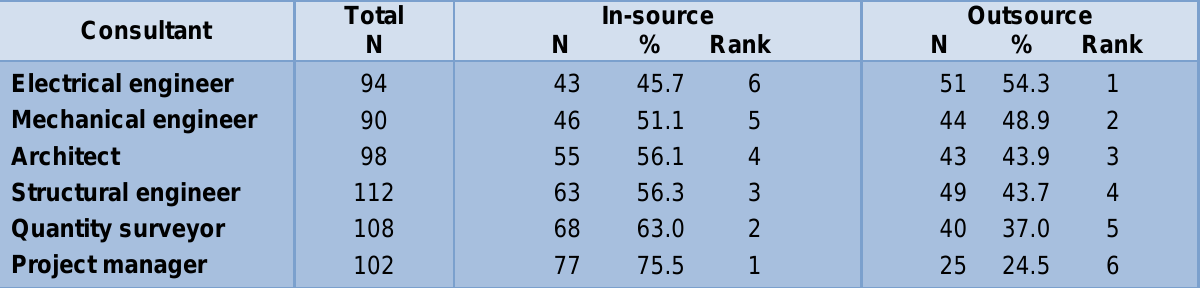
Table 2 Ranks of the sources of selected project consultants N=Number of